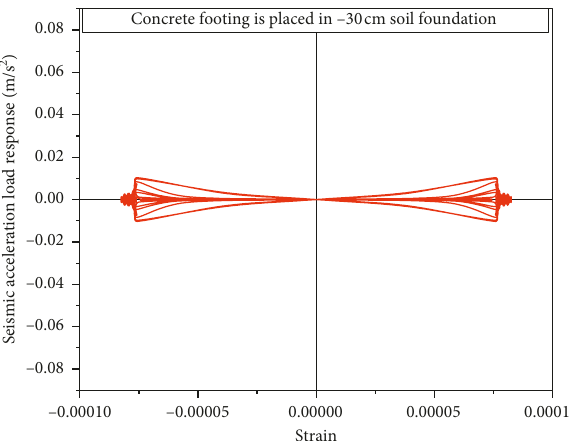
Figure 11: Shear stress vs shear strain at the base of a concrete footing, during concrete footing-soil foundation interaction.